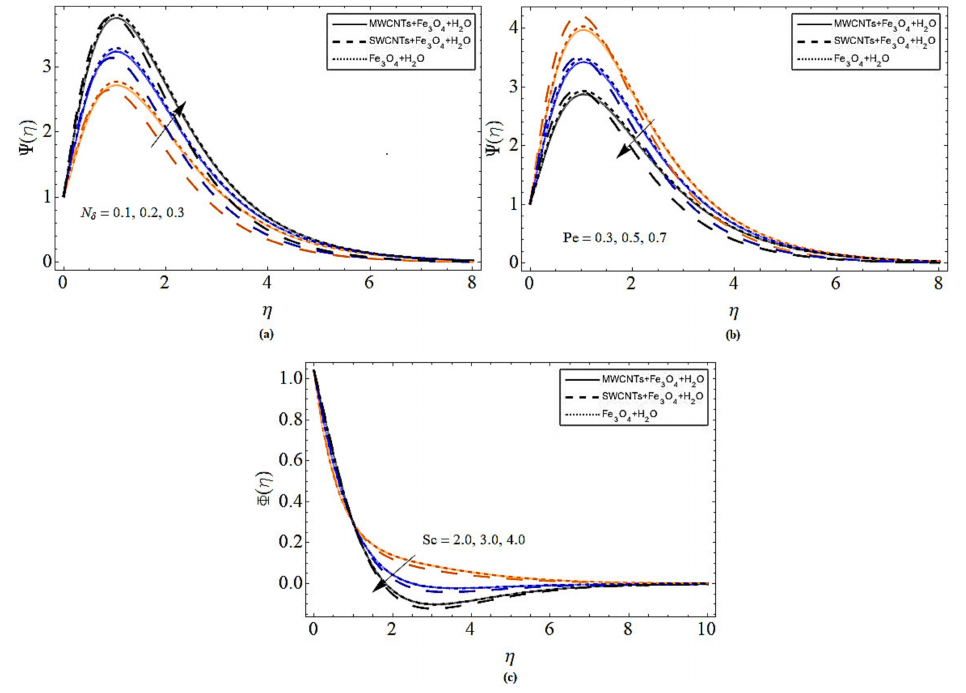
Figure 5. The behavior of motile microorganism Ψ ( η ) and mass transfer profile Φ ( η ) versus ( a ) mi- croorganisms distributions ratio N δ ; ( b ) bioconvective Peclet number Pe ; and ( c ) Schmidt number Sc .